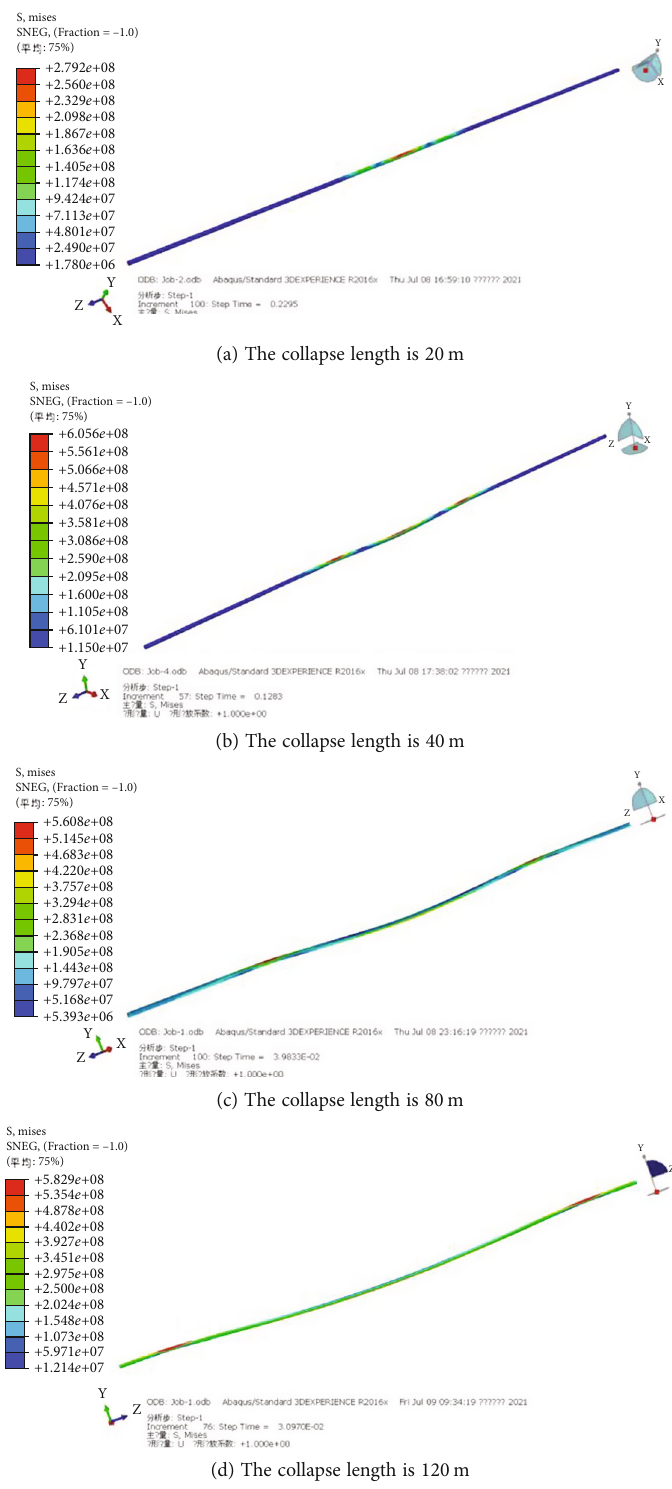
Figure 6: Pipeline stress under di ff erent collapse